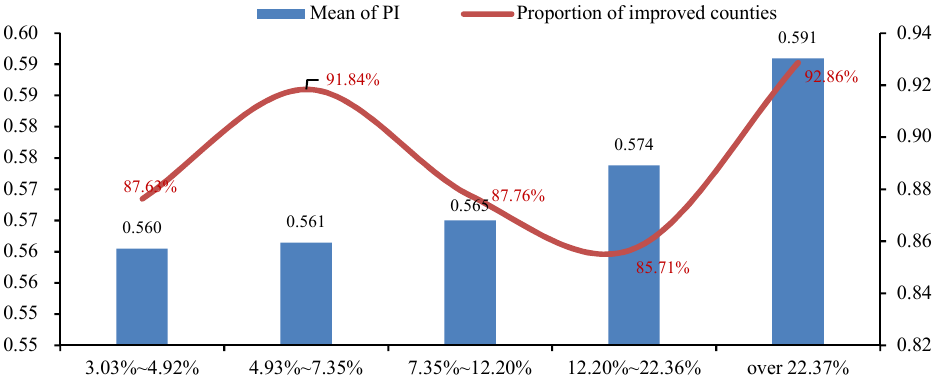
Figure 11. Percentage of the PI in groups of PA